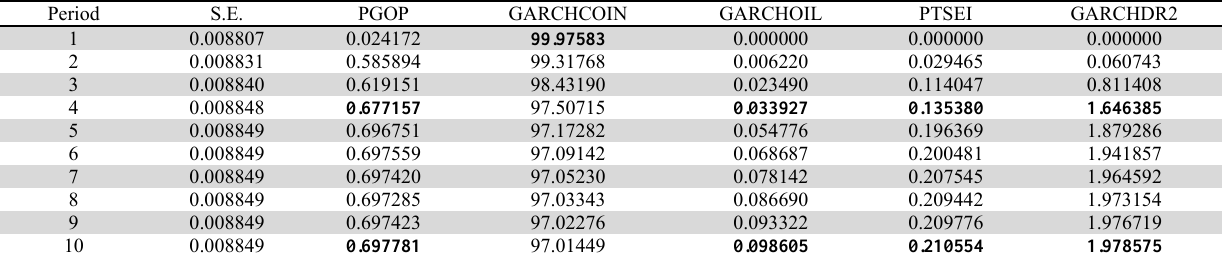
The summary of analysis of